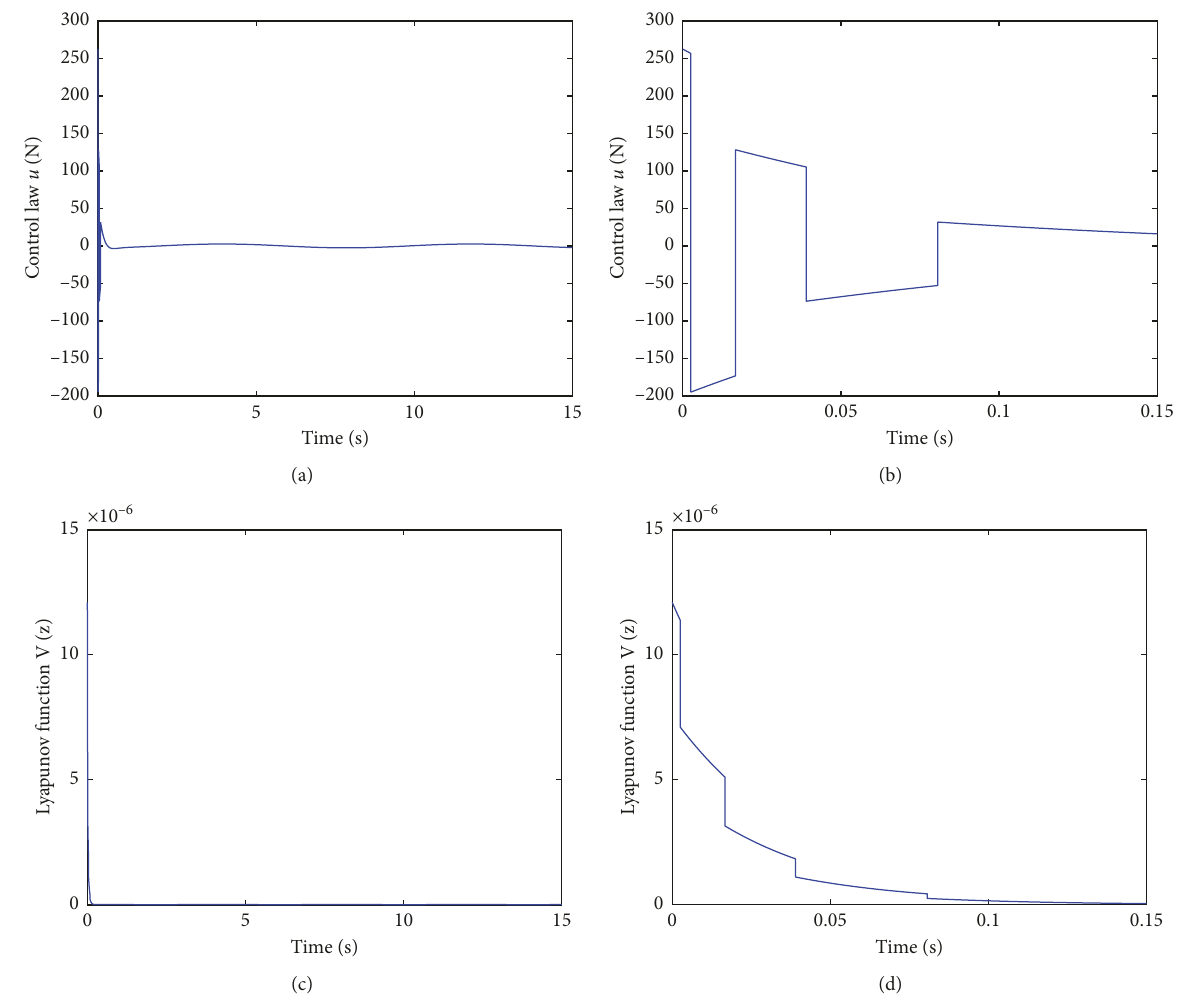
Figure 7: Simulation results for the case d � 0 . 1 showing the temporal variation of the controller u and the Lyapunov function V ( z )